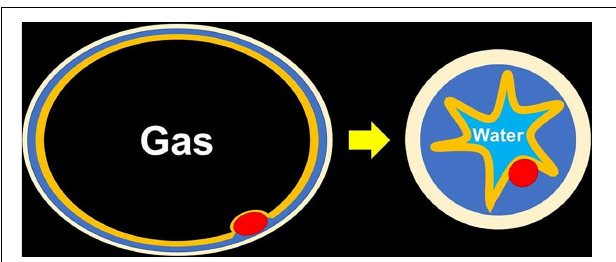
FIGURE 4 | Changing of thickness of the submucosa seen with water immersion. After fully exchanging the gas for water, the muscularis becomes circular and contracted, which makes the submucosa thickened and easy to be snared even without submucosal injection.